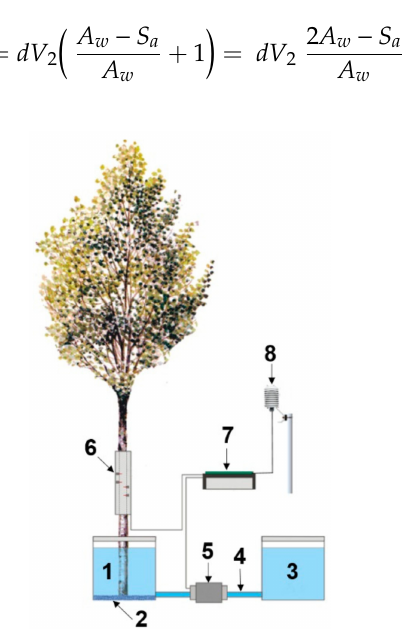
Figure 1. Experimental setup: ( 1 ) Potometer with the first water reservoir, ( 2 ) porous layer, ( 3 ) second water reservoir, ( 4 ) connection pipe, ( 5 ) high precision flow meter sensor, ( 6 ) sap flow sensors, ( 7 ) data acquisition system, ( 8 ) temperature and relative humidity sensor.